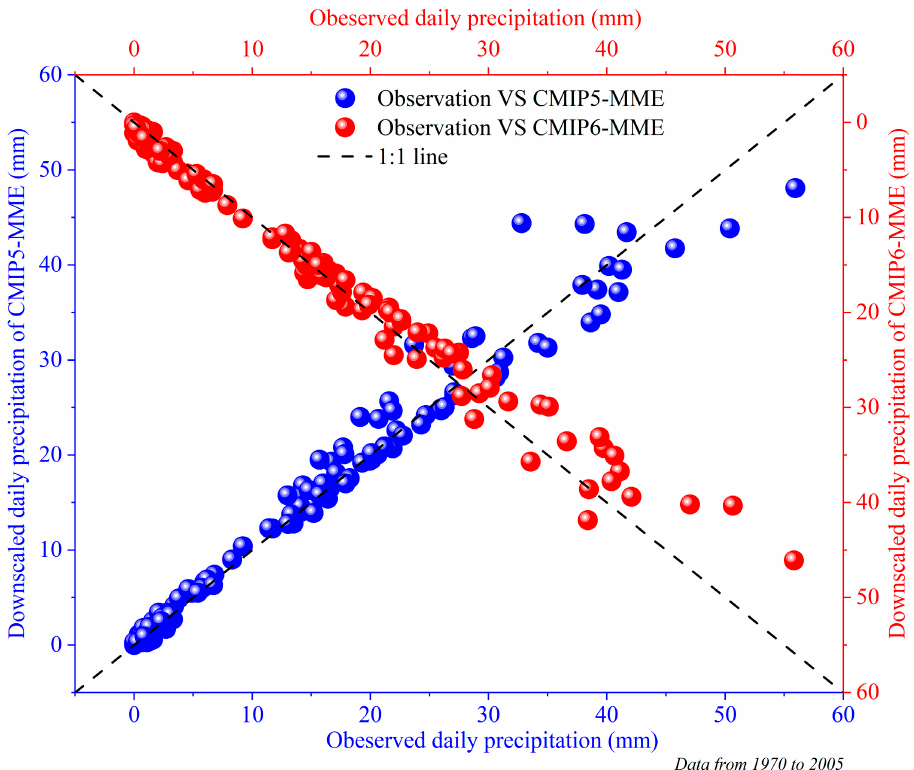
Figure 4. Quantile-quantile plots of observed versus (VS) GCM daily precipitation data of CMIP5-MME and CMIP6-MME for each station.